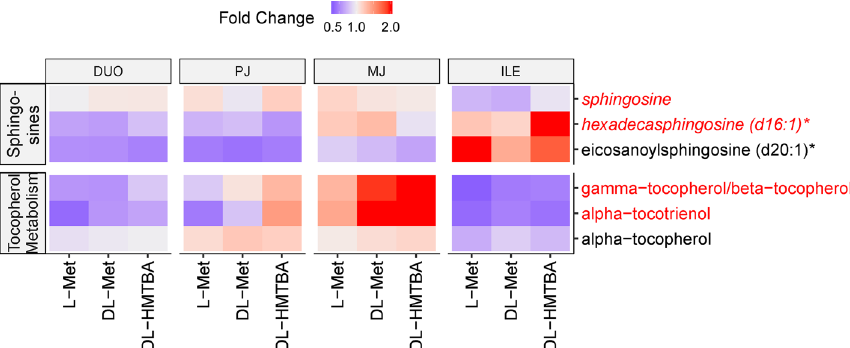
Figure 5. Heat map of sphingosines and the tocopherol metabolism pathway, showing the distribution of all measured pathway-related metabolites along duodenum (DUO), proximal jejunum (PJ), middle jejunum (MJ) and ileum (ILE) in pigs pre-fed with L-Met, DL-Met or DL-HMBTA. Blue color indicates lower abundance whereas red color indicates higher abundance of metabolites. Red writing of individual metabolites indicates a treatment effect or, if combined with italics, a region × treatment interaction ( P < 0.10).